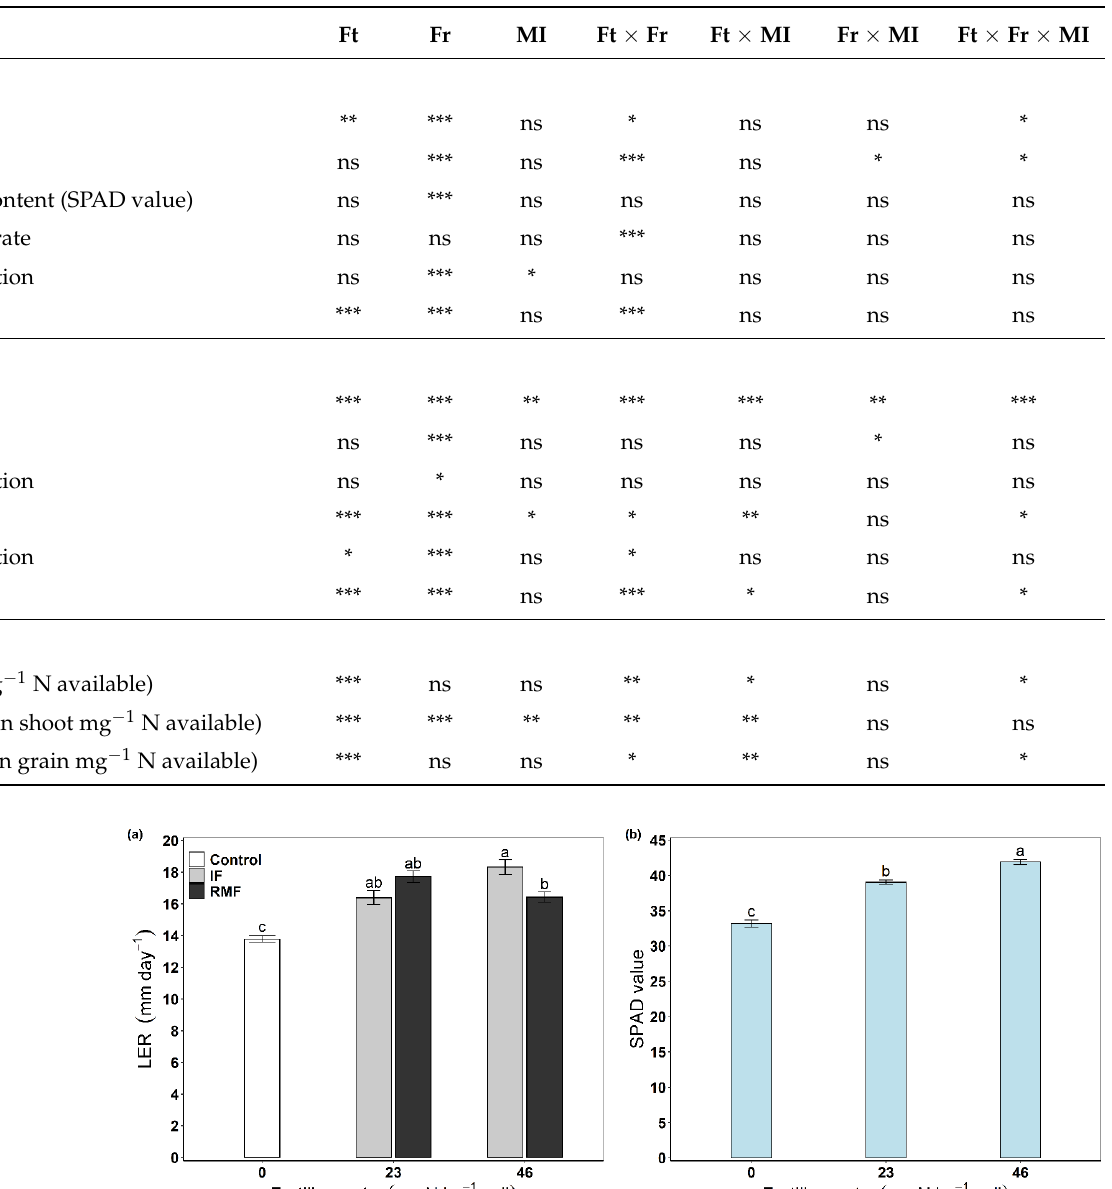
Figure 1. ( a ) Effect of fertiliser type (Ft) × fertiliser rate (Fr) (mean ± SE, n = 8) on 3 rd leaf extension rate (LER) and ( b ) main effect of Fr (mean ± SE, n = 16) on chlorophyll content (SPAD value). Mean values followed by the same letter are not statistically different as per Tukey ’ s HSD at p ≤ 0.05. Three-way ANOVA (Table 1) showed the significant interaction effect of Ft × Fr ( p =< 0.001) on LER and only the significant main effect of Fr ( p =< 0.001) regarding chlorophyll content. Control, no fertiliser; IF, inorganic fertiliser; RMF, rock mineral fertiliser. At both growth stages, shoot dry weight was affected by the significant three-way interaction fertiliser type × fertiliser rate × MI ( p = 0.042 at anthesis and p ≤ 0.001 at ma- turity) (Table 1). At anthesis, the interaction effect was because of greater shoot dry weight in RMF than IF at 23 mg N kg −1 soil without MI, with no fertiliser type differences with MI inoculation (Figure 2a). At maturity, the interaction effect was observed because of the higher shoot dry weight in RMF than IF at 23 and 46 mg N kg −1 soil with (but not without) MI (Figure 2b). Table 1. Analysis of variance (ANOVA) summary for wheat growth, N concentration and NUE parameters as influenced by fertiliser type (Ft), fertiliser rate (Fr), microbial inoculant (MI) and their interactions at anthesis and maturity. *, ** and *** denote significance at p ≤ 0.05, 0.01 and 0.001, respectively; ns, non-significant at p > 0.05. Variables